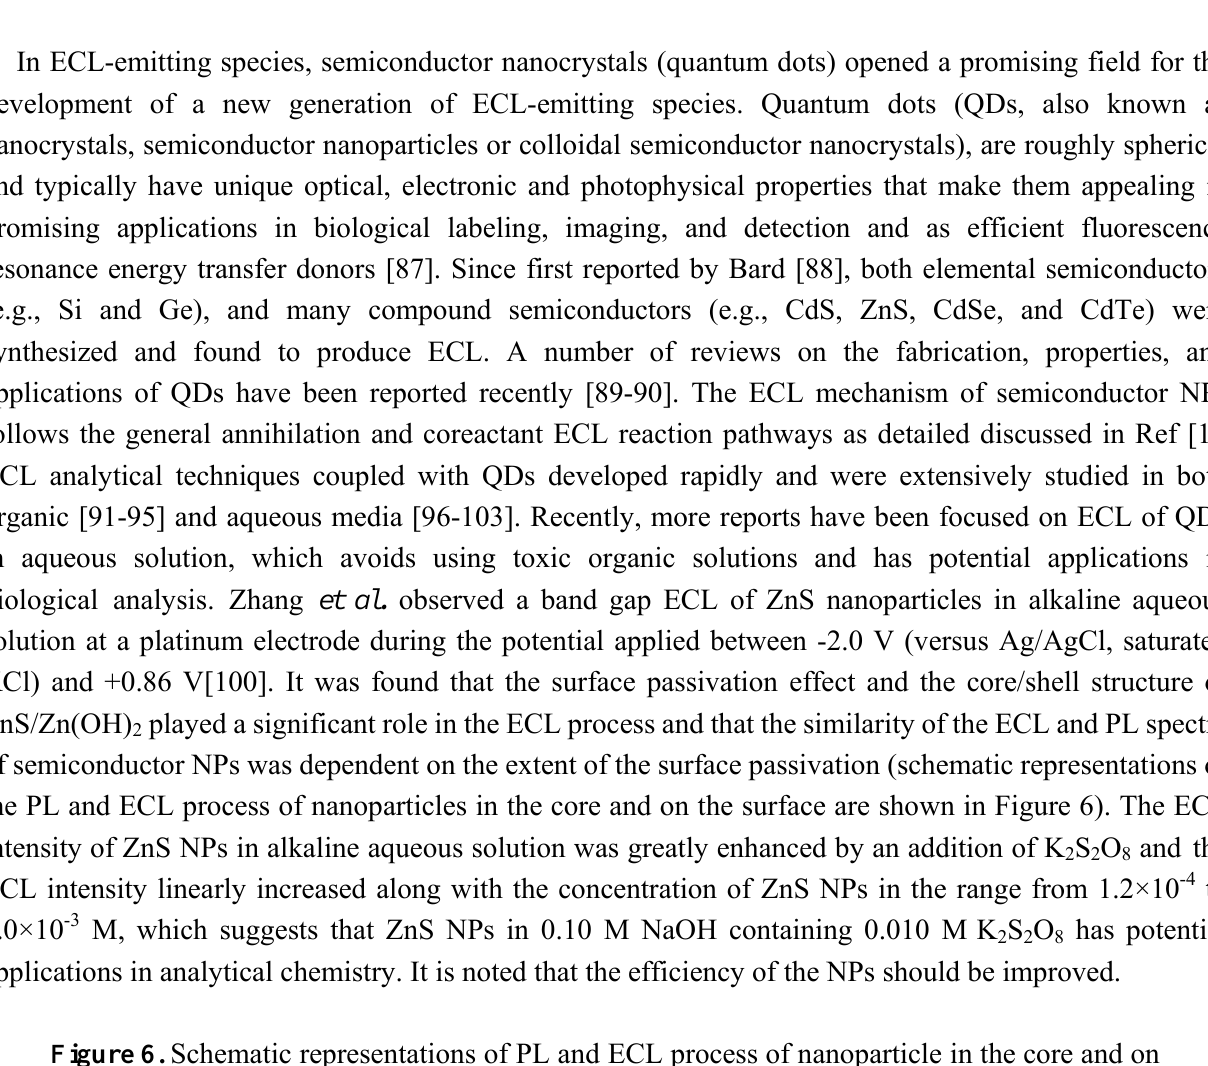
Figure 6. Schematic representations of PL and ECL process of nanoparticle in the core and on the surface. Reprinted from Ref [100] with permission from The American Chemical